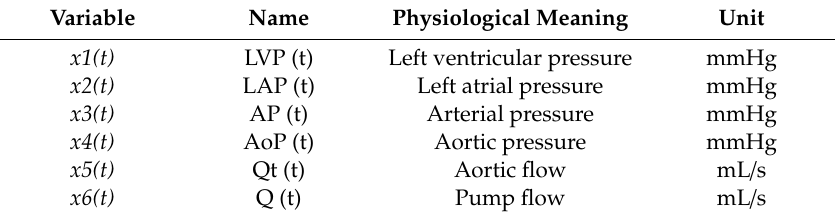
Table 4. State variables of the coupled model.